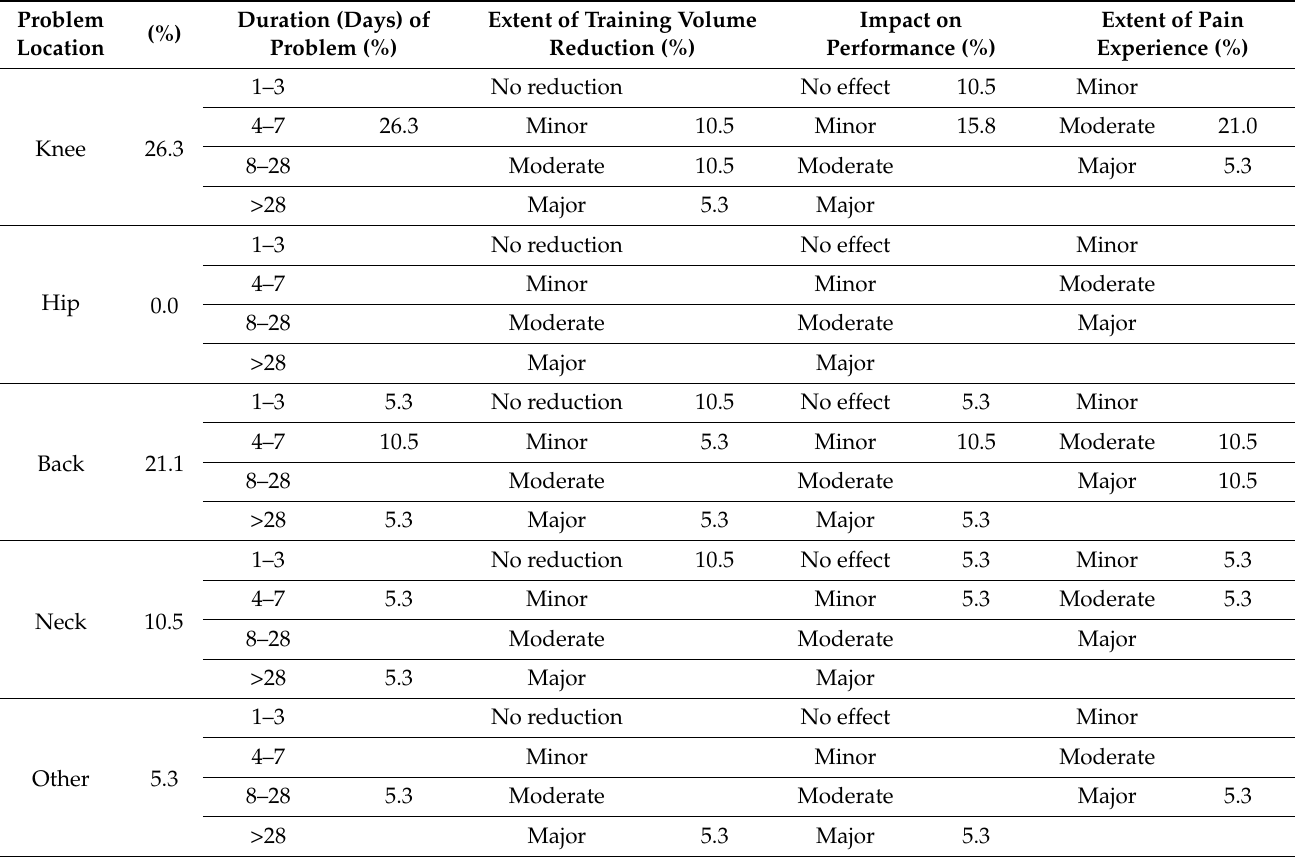
Table 6. Location and severity of overuse